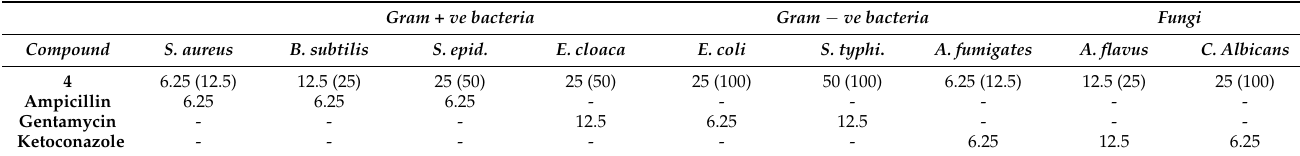
Table 4. The MIC (MBC/MIc) in µ g/mL of compound 4